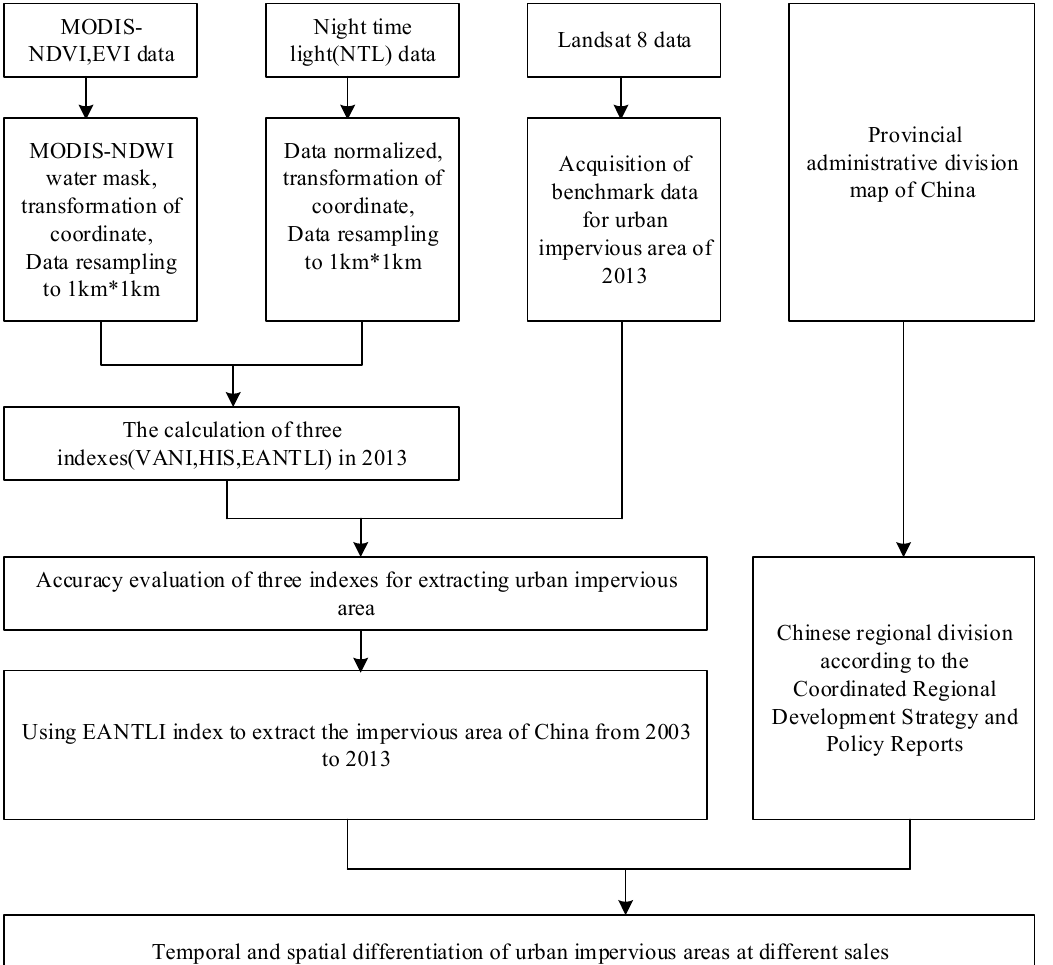
Figure 2. The steps of the spatiotemporal patterns of urban imperious surfaces (IS).